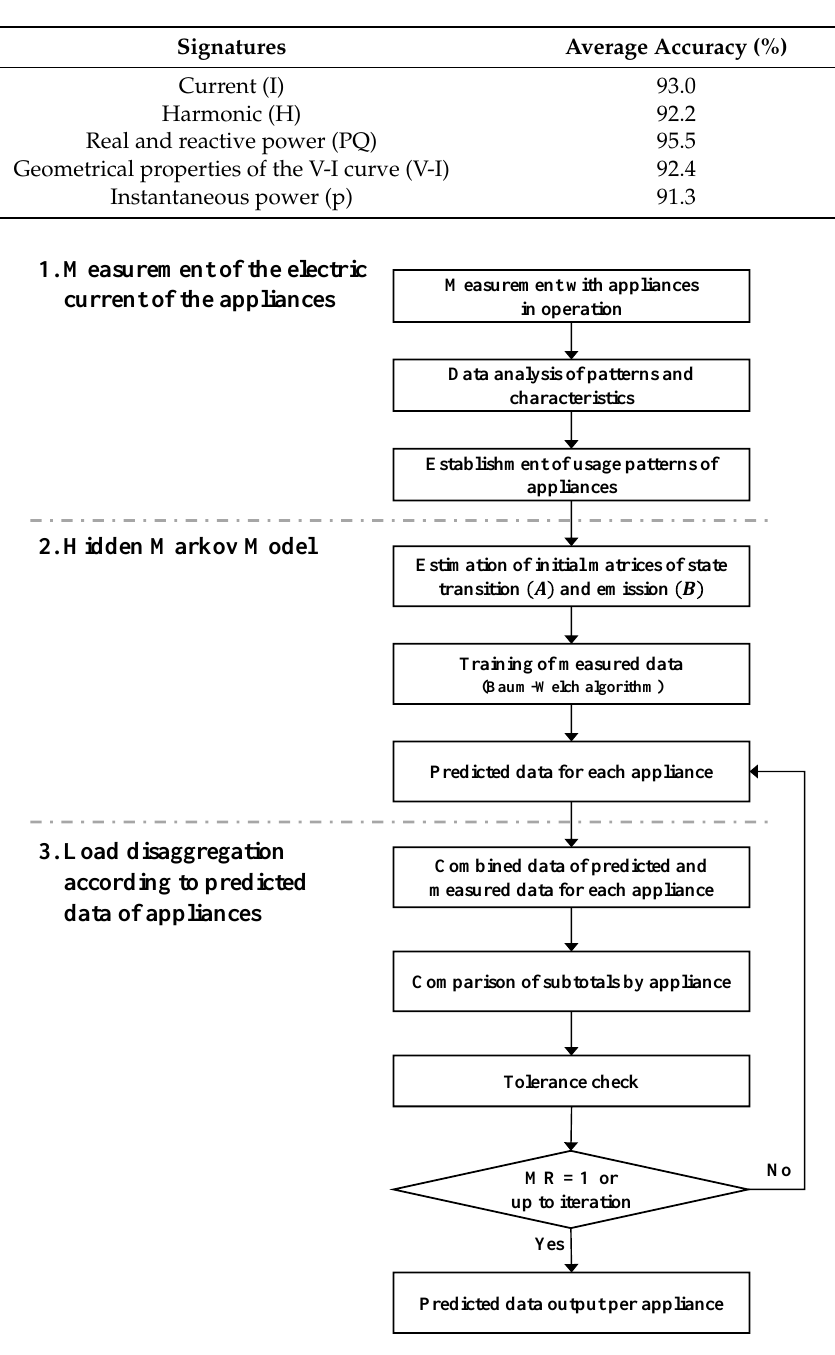
Figure 1. Flowchart of the study.